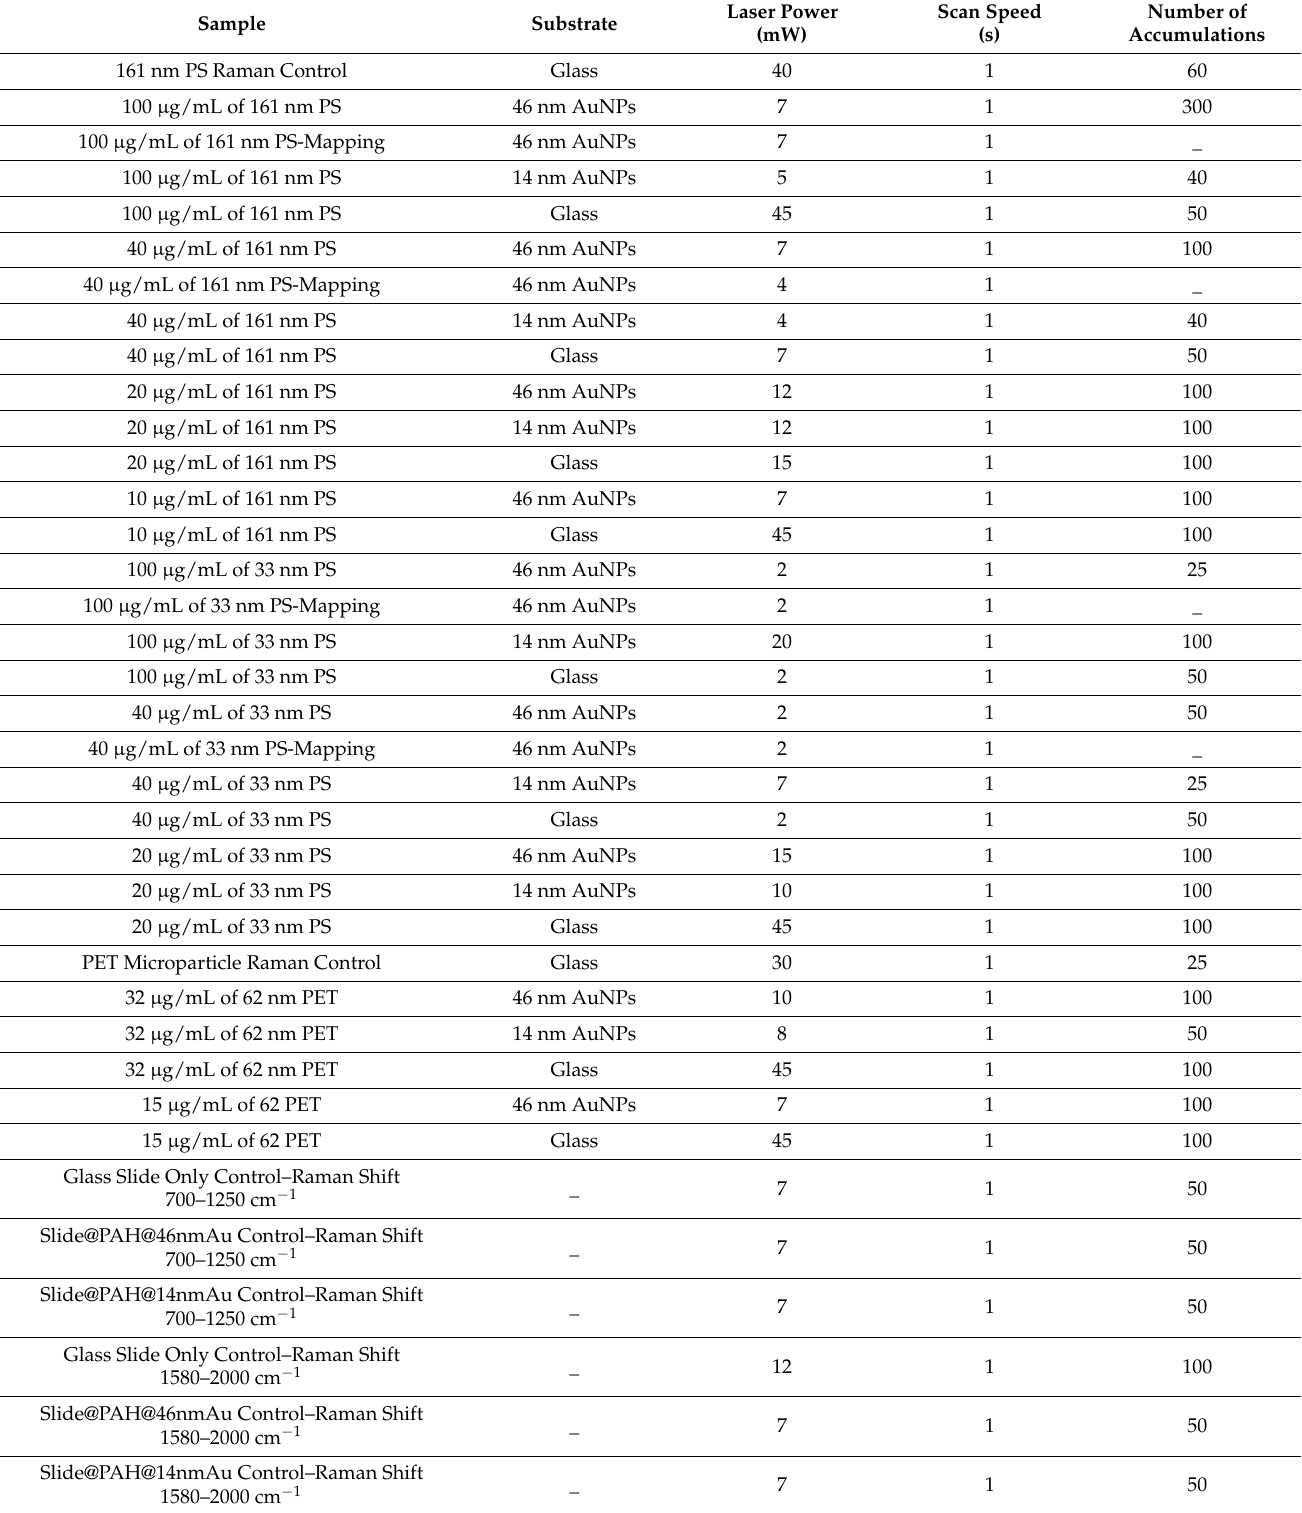
Table A1. A summary of measurement parameters utilized to obtain the final spectra presented for each sample.